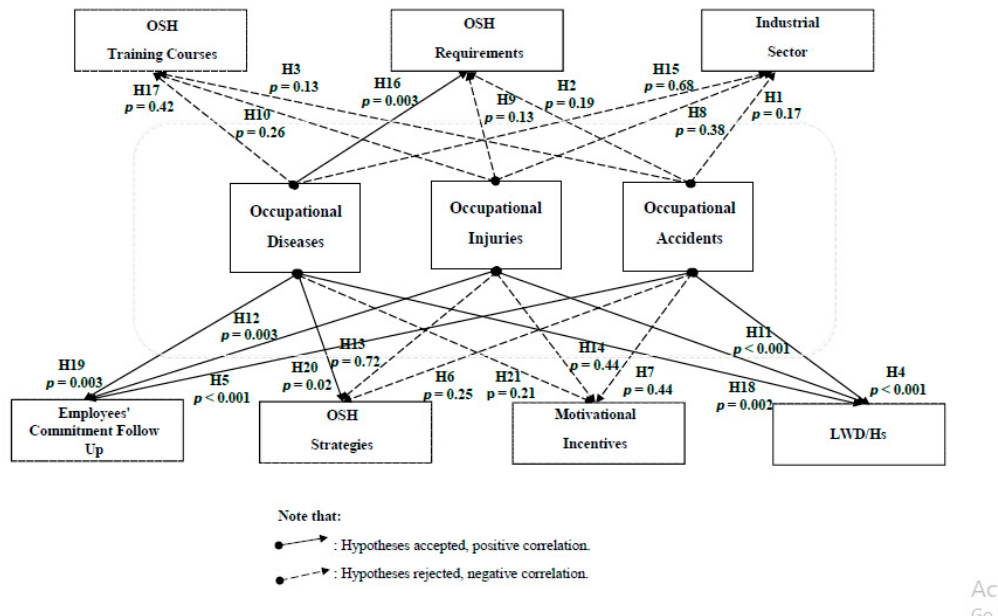
Figure 20. The presentation of case correlation (1) and its hypothesis testing. LWD/h is the loss of working days or hours.